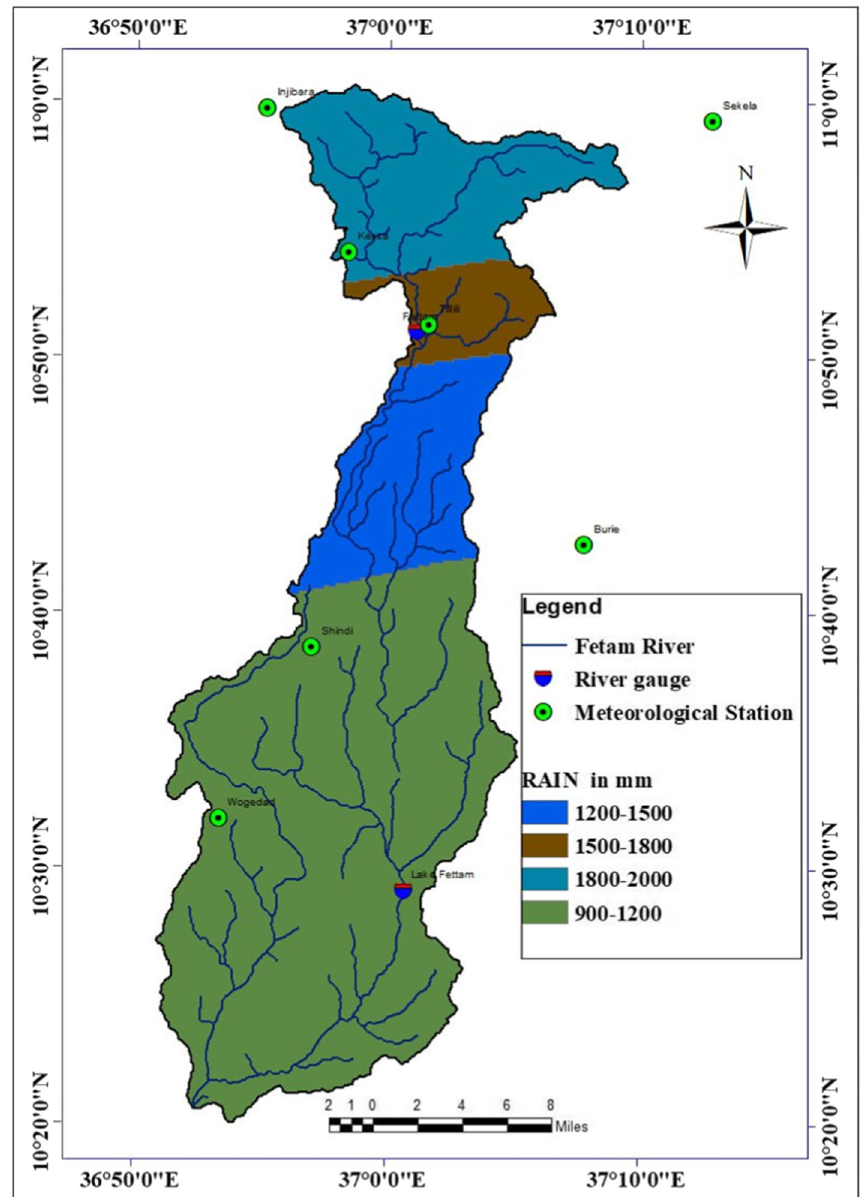
Fig. 4 The location of meteoro- logical and hydrological gauge and rainfall distribution